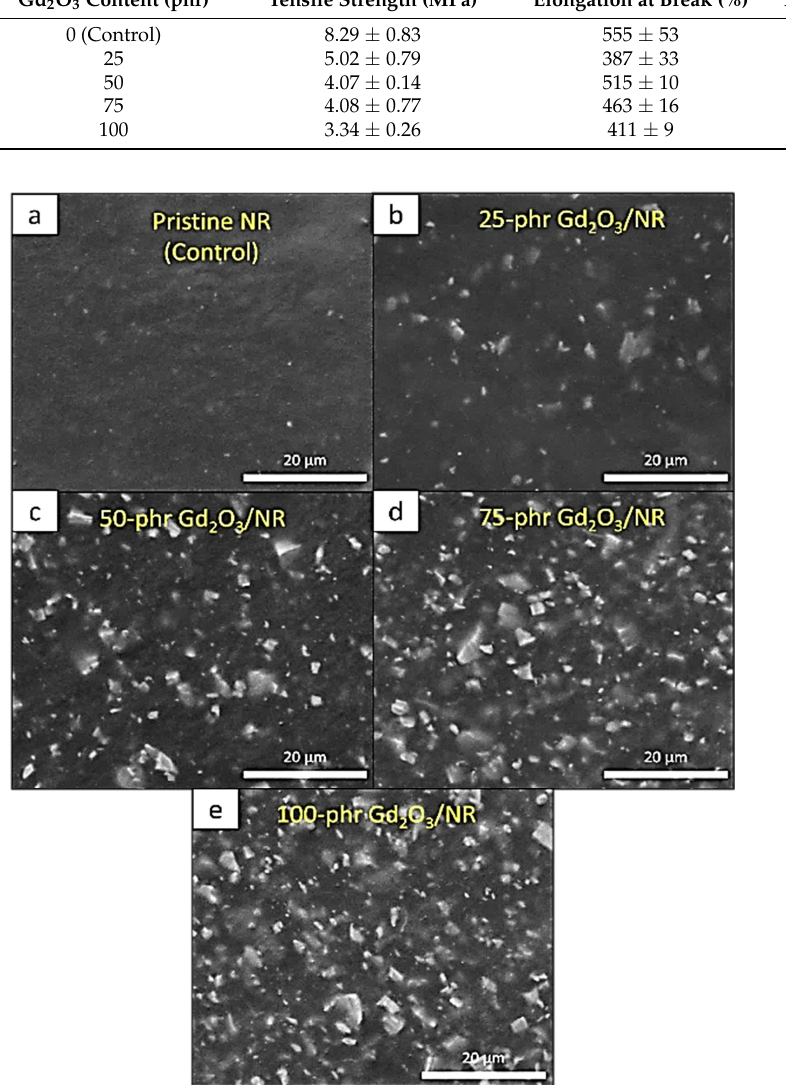
Figure 8. SEM images showing morphology and particle dispersion of NR composites containing varying Gd 2 O 3 contents: ( a ) 0, ( b ) 25 phr, ( c ) 50 phr, ( d ) 75 phr, and ( e ) 100 phr.